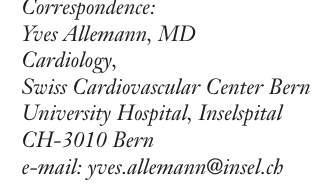
Transoesophageal echocardiography.